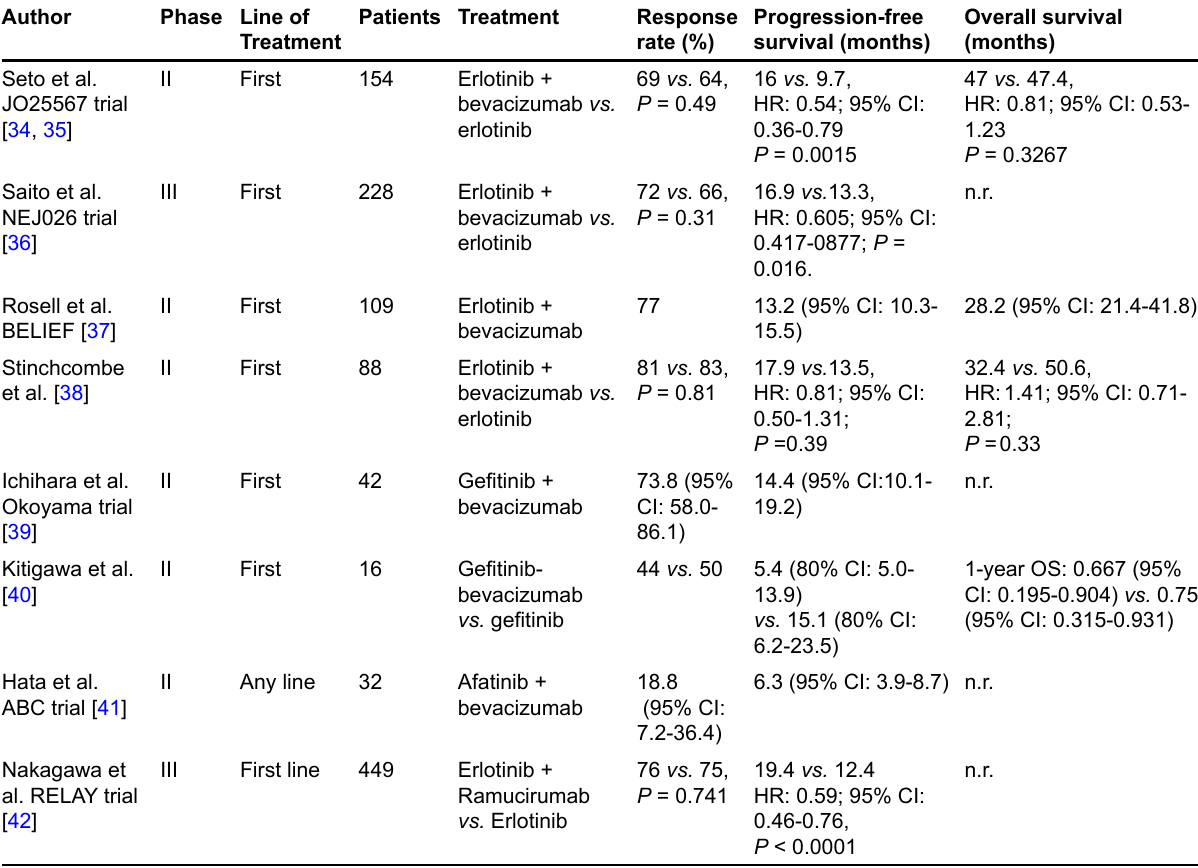
Table 3. VEGF and EGFR TKIs in EGFR mutated NSCLC